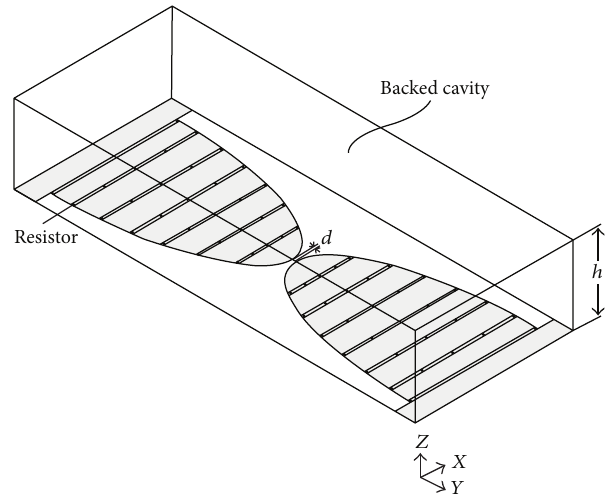
Figure 1: Geometry of the resistor-loaded